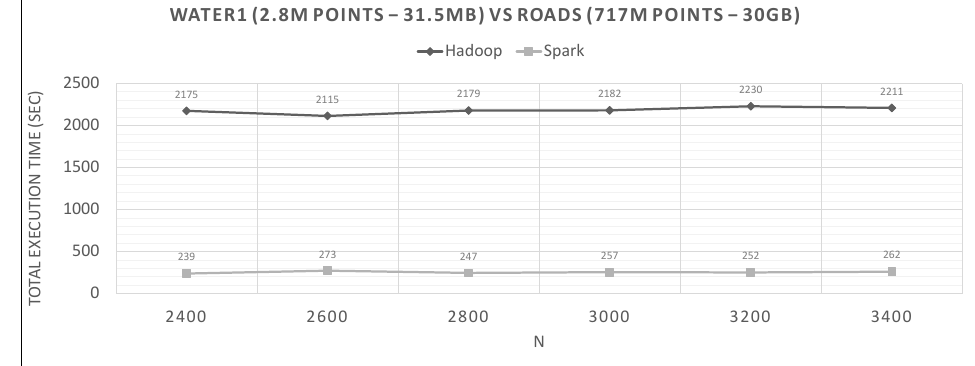
Figure 26. Hadoop vs. Spark, hydro (def. loc.) query and large training datasets.